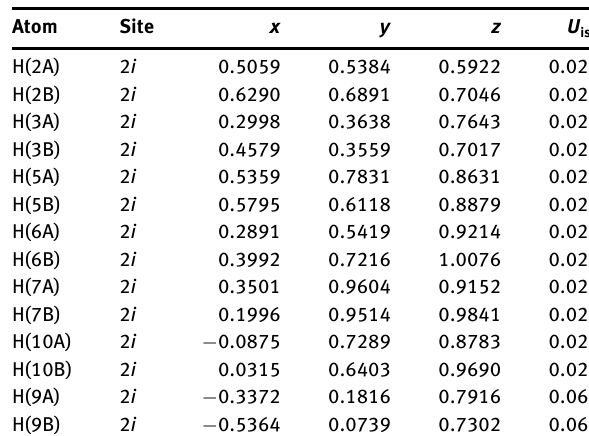
Table 2: Fractional atomic coordinates and isotropic or equivalent isotropic displacement parameters (Å 2